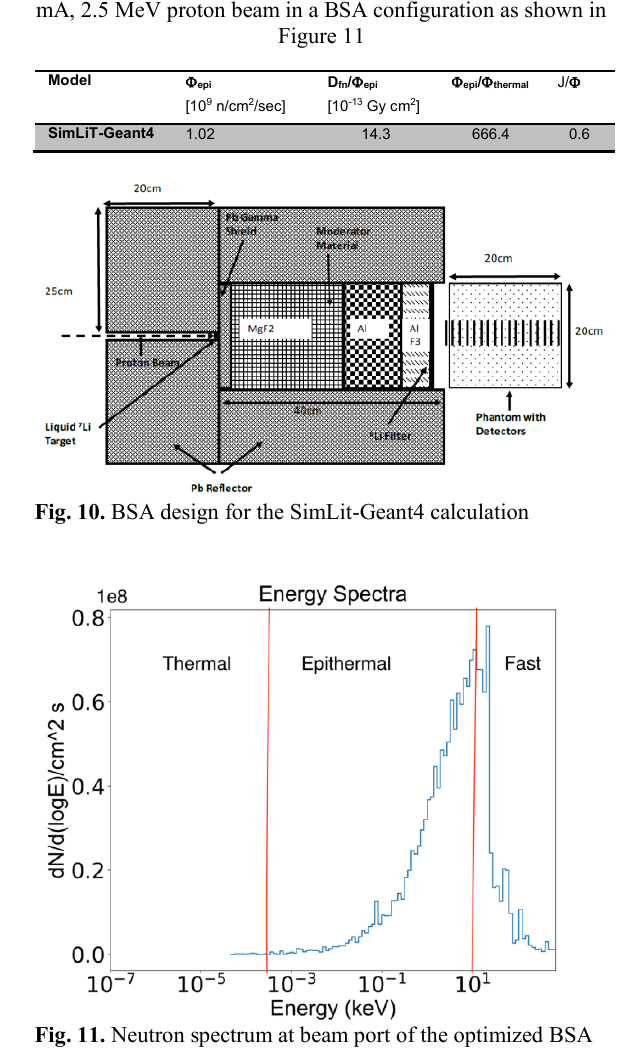
Table 5. Calculated neutron beam quality parameters for 20 mA, 2.5 MeV proton beam in a BSA configuration as shown in